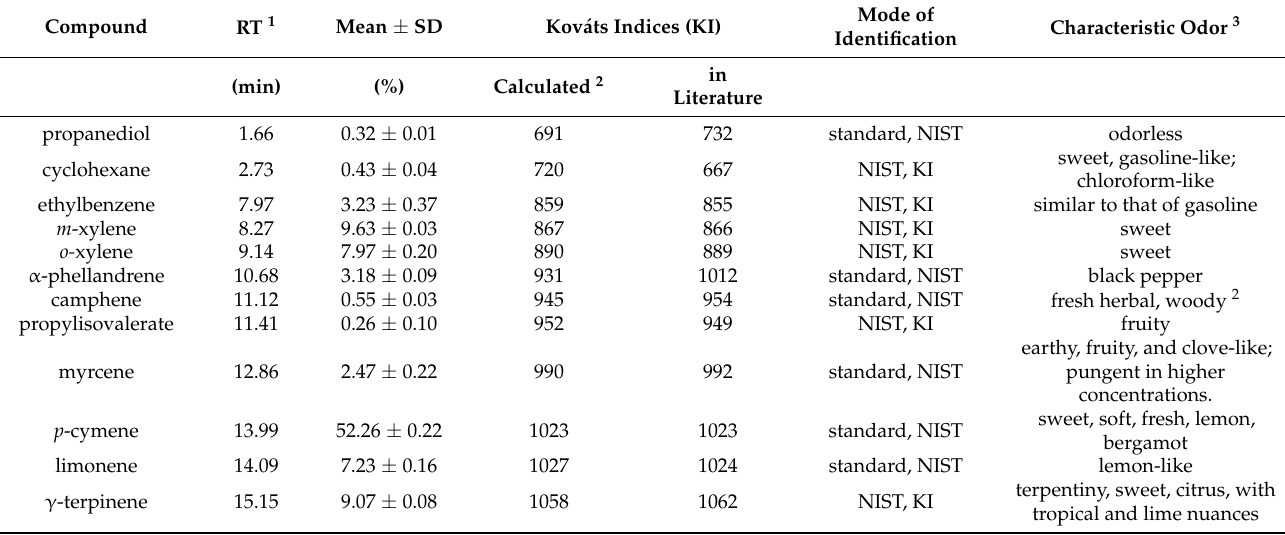
Table 6. Relative proportions of volatile compounds emitted by O. serrulata